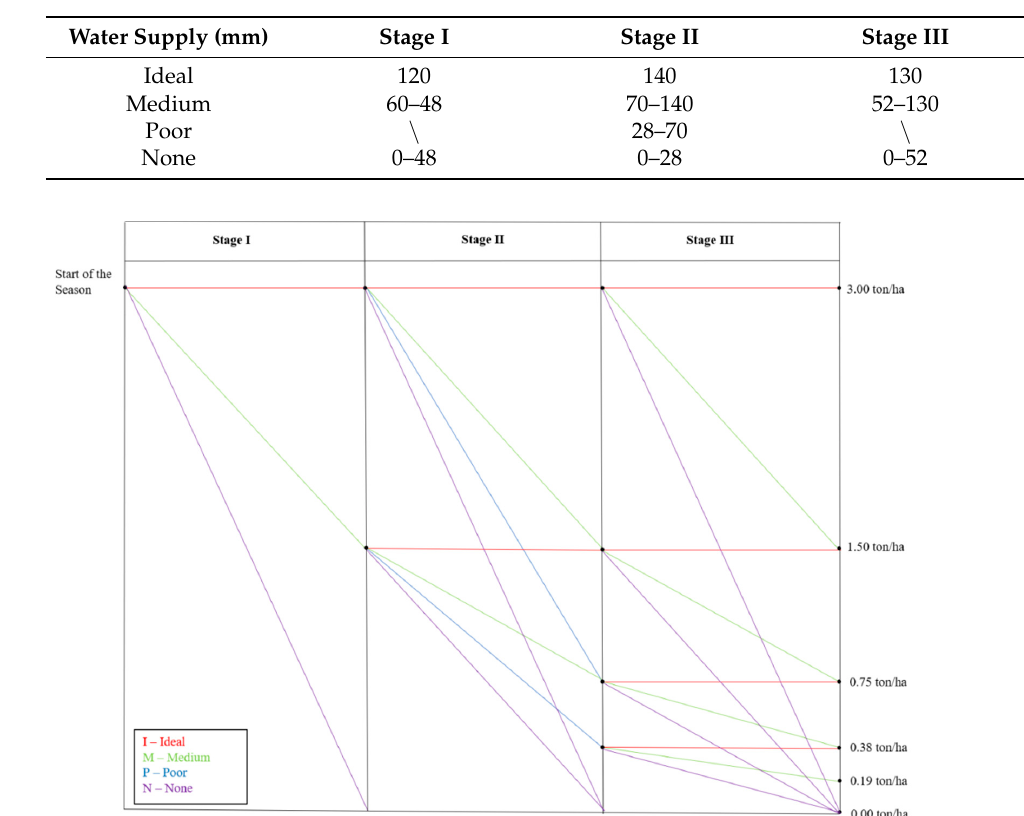
Figure A2. Simplified barley yields response to supplied water